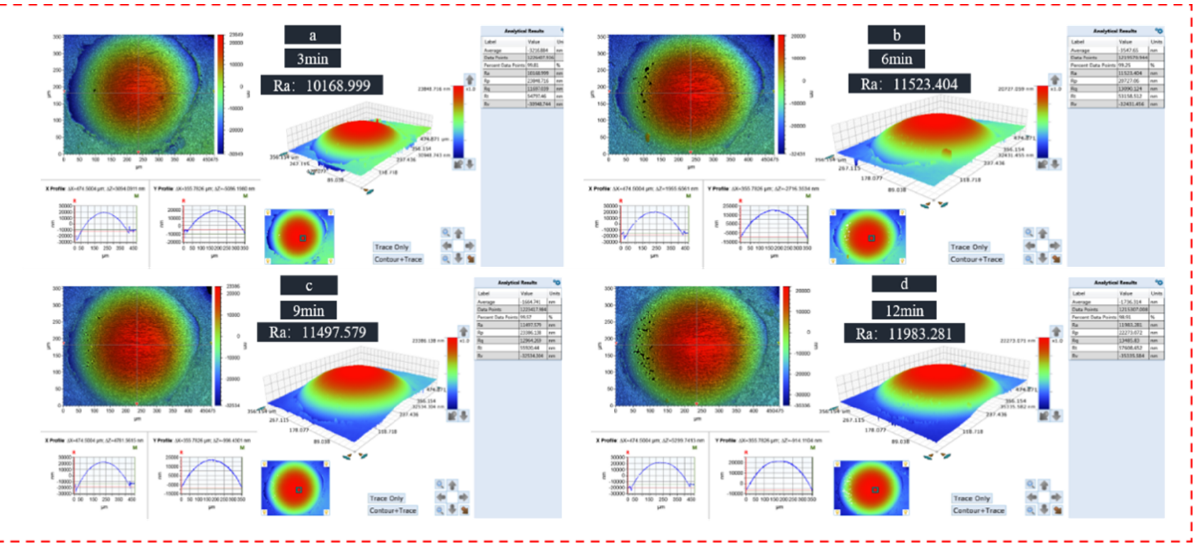
Figure 12. 3D morphology after wear. ( a ) Wear for 3 min; ( b ) wear for 6 min; ( c ) wear for 9 min; and ( d ) wear for 12 min.